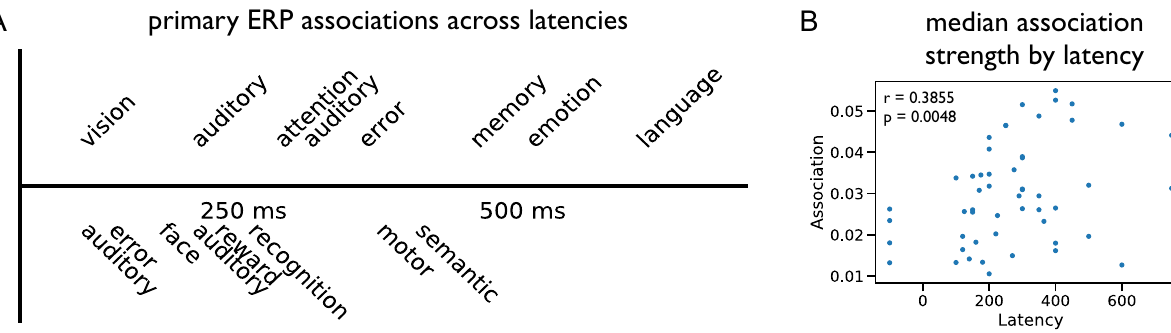
Figure 7. ERP associations across latencies. ( A ) Primary associations for each ERP were extracted from the co-occurrence analysis, and ERPs were plotted across time based on their typical peak latency. In general, earlier components tend to reflect sensory processing, whereas later components increasingly relate to more cognitive processes. For visualization purposes, only components with more than 250 articles are shown in this figure. ( B